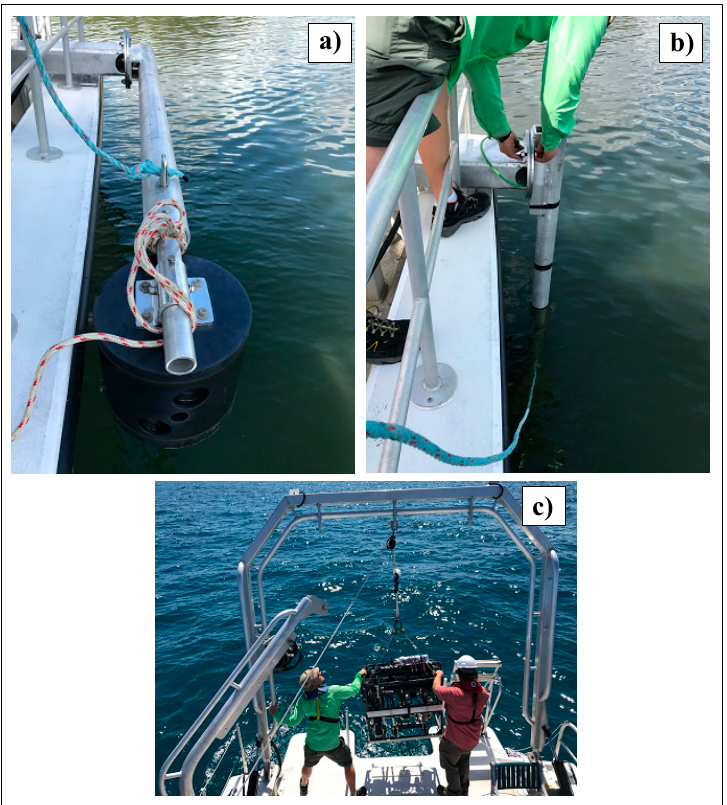
Figure 2. Oculus deployment. Standby position ( a ), operational position ( b ), optical package launch ( c ).